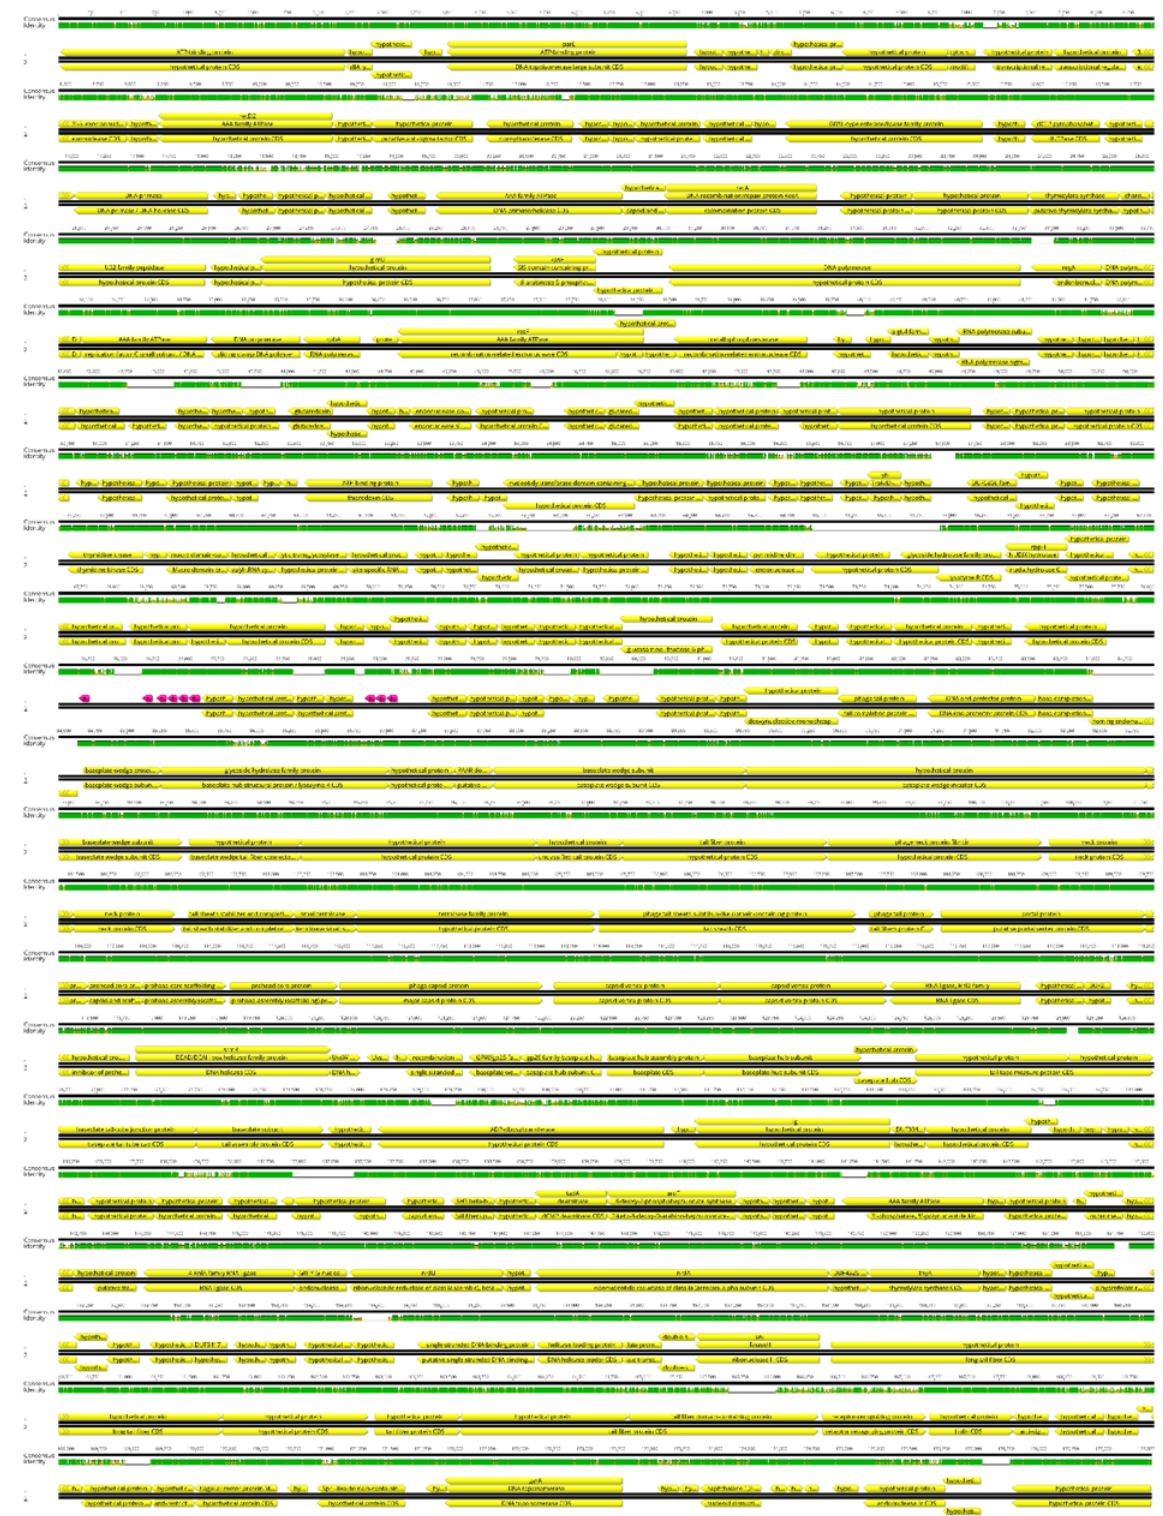
Figure 5. Graphical representation of phage Entb_45 (no. 1), aligned to the most similar known genome of Enterobacter phage ENC9 (no. 2, acc. no. OL355124.1). Green—100%, brown-green—between 30% and 100%, and red—0% local similarity. Lack of color shows a gap in alignment. Annotation is shown for reference. Coding sequences (CDS) are yellow, and tRNA coding sequences are pink.